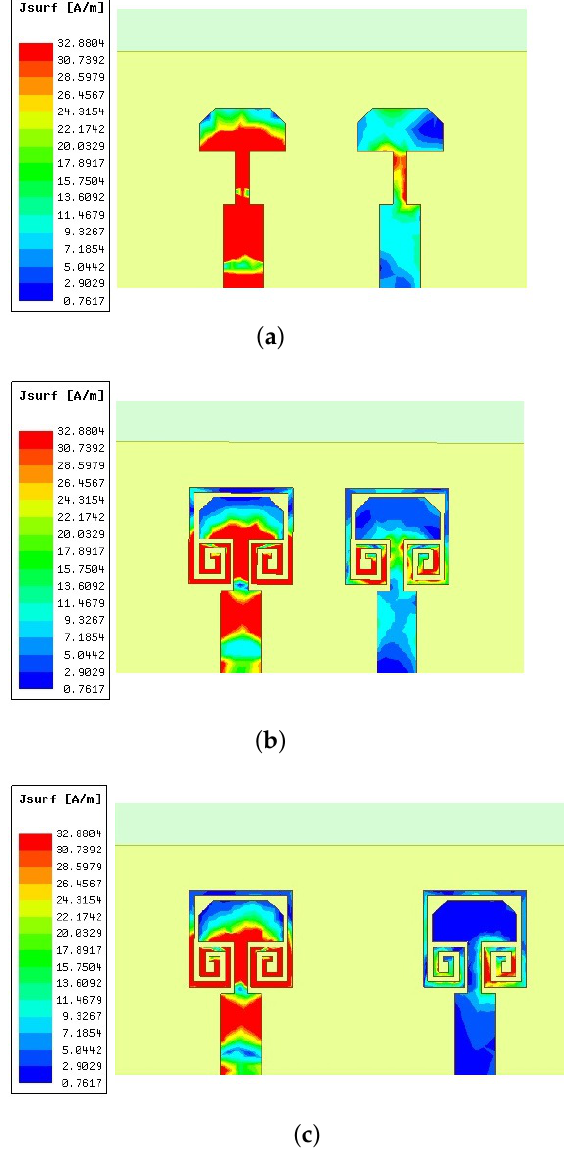
Figure 8. Surface current distribution of different configurations at 28 GHz. ( a ) Without parasitic ( d = 0.19 λ 0 ) ( b ) With parasitic ( d = 0.19 λ 0 ) ( c ) With parasitic ( d = 0.54 λ 0